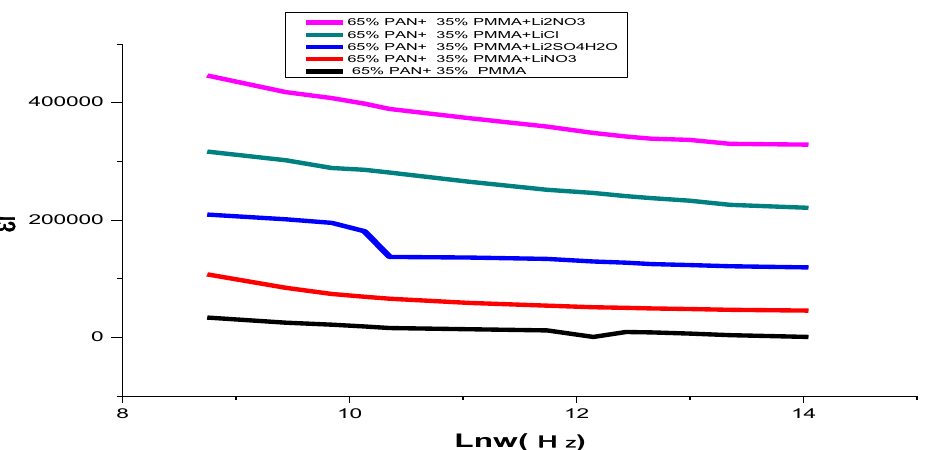
Figure 2d: The real dielectric constant as function of ln (ω) of undoped (65%PAN +35%PMMA) and doped with 20% (LiNO